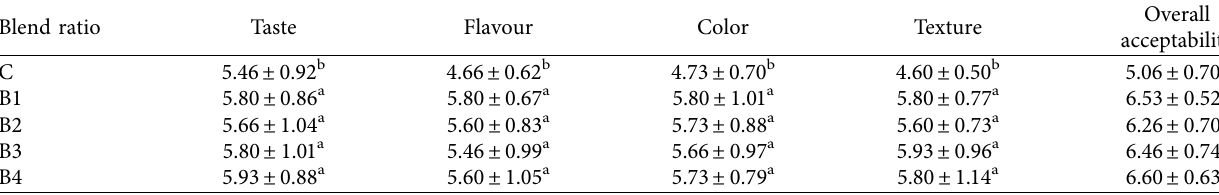
Table 5: Sensory property of the composite